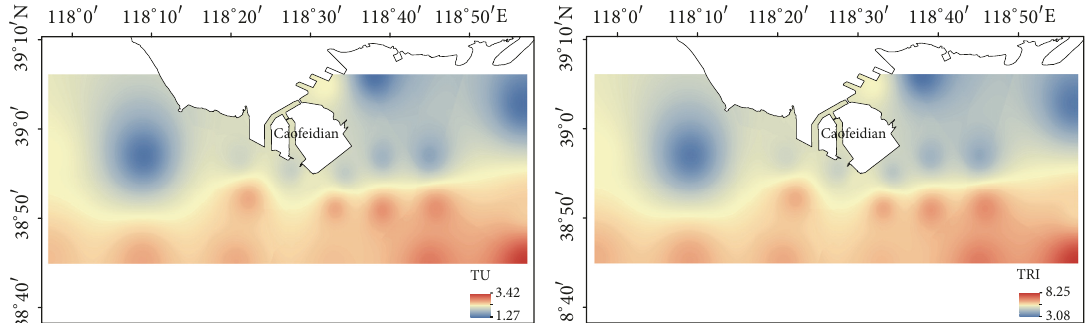
Figure 4: The spatial distribution of the TUs and TRI of heavy metals in the